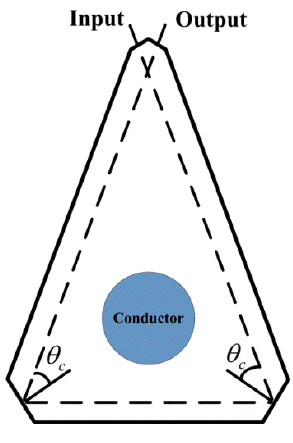
Figure 10. Bulk optic triangular shape current